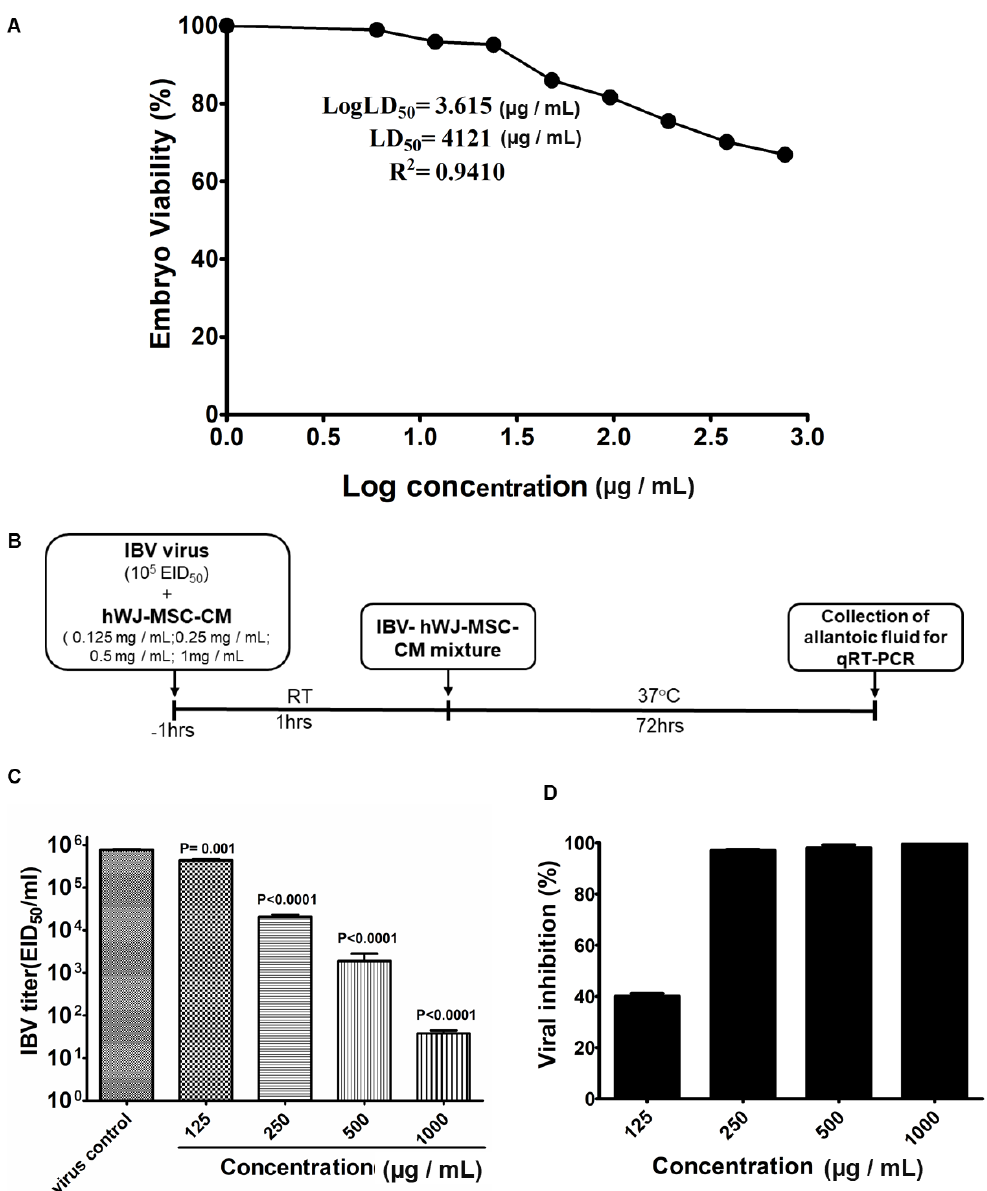
Figure 4. In ovo toxicity and anti-IBV activity of hWJ-MSC-S. ( A ) Lethal Dose 50 (LD 50 ) of hWJ-MSC-S in SPF-ECEs. The LD 50 was assessed by inoculating SPF-ECEs with different hWJ-MSC-S concentrations and embryo viability was checked daily. The LD 50 was calculated as the concentration that causes the death of 50% of inoculated embryos. ( B ) Schematic depicting the experimental protocols used for the assessment of in ovo toxicity and anti-IBV activity of hWJ-MSC-S. ( C ) Reduction in viral titer after treatment of IBV with different concentrations of hWJ-MSC-S (125, 250, 500, 1000 µ g/mL). ( D ) Percentages of IBV inhibition after treatment with different concentrations of hWJ-MSC- S (125, 250, 500, 1000 µ g/mL). Results are shown as means ± SD of three independent experiments, each run in